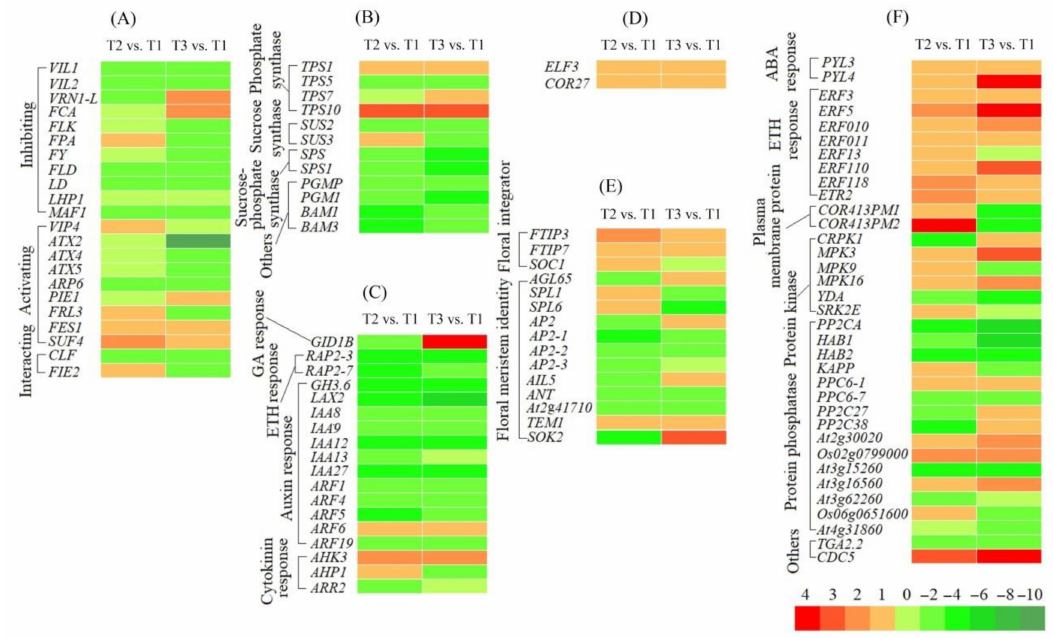
Figure 5. Heat map of the 104 DEGs involved in flowering at T2 vs. T1 and T3 vs. T1. The differential expression level is based on FPKM values; gene abbreviations are provided in Tables S3–S8. The subfigures ( A ): FLC expression, ( B ): sucrose metabolism, ( C ): hormone response, ( D ): circadian clock, ( E ): downstream floral integrators and meristem identity, and ( F ): cold response.